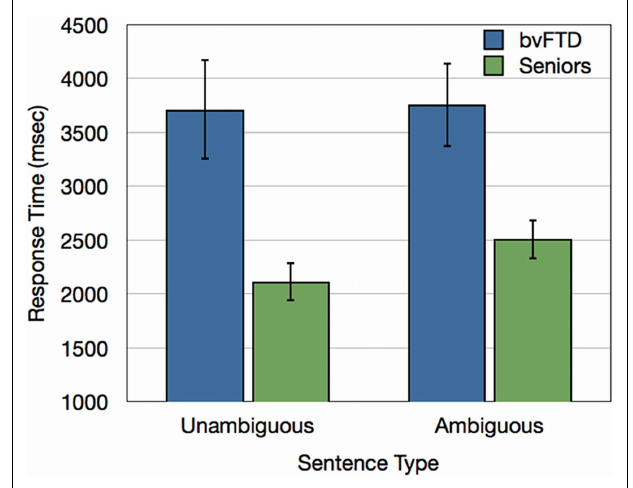
FIGURE 4 | Response times (ms) for bvFTD patients and healthy seniors for unambiguous baseline sentences and ambiguous doubly-quantified